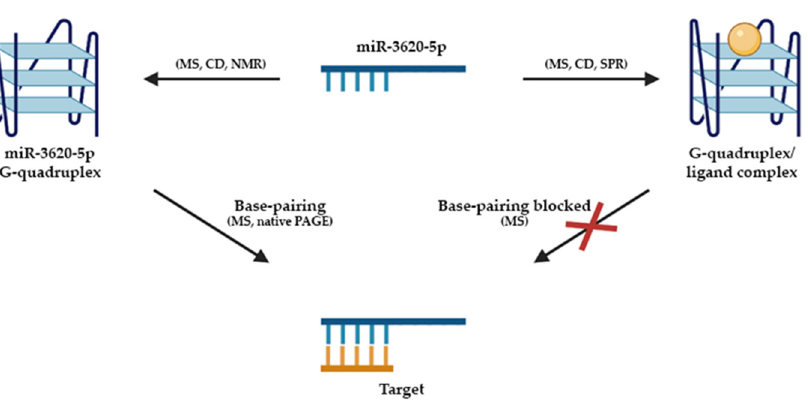
Figure 9. Representation of G4 formation in miR-3620-5p and the inhibition effect of sanguinarine on the base pair formation of miR-3620-5p with its target sequence. Adapted from ref. [73]. Copyright (2016), with permission from Elsevier.